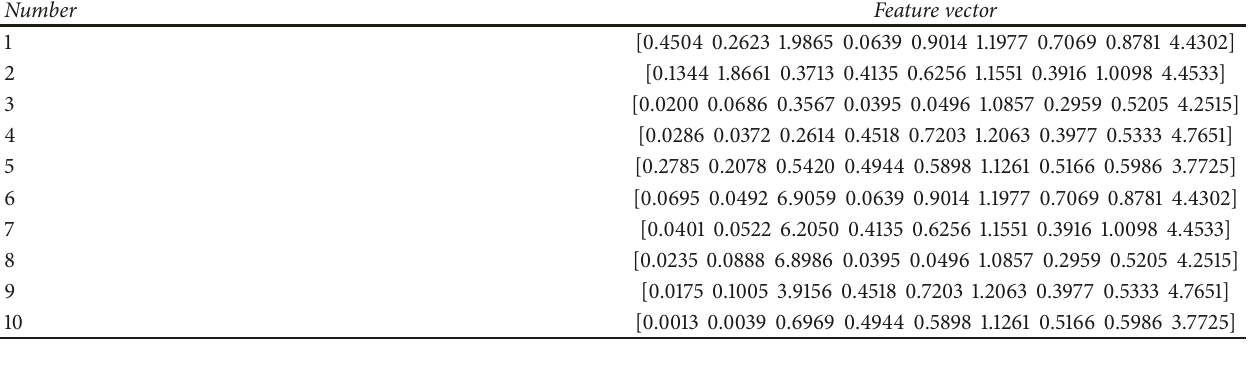
Table 1: The multiwavelet entropy of corn’s multiwavelet entropy of the normal growing condition group.